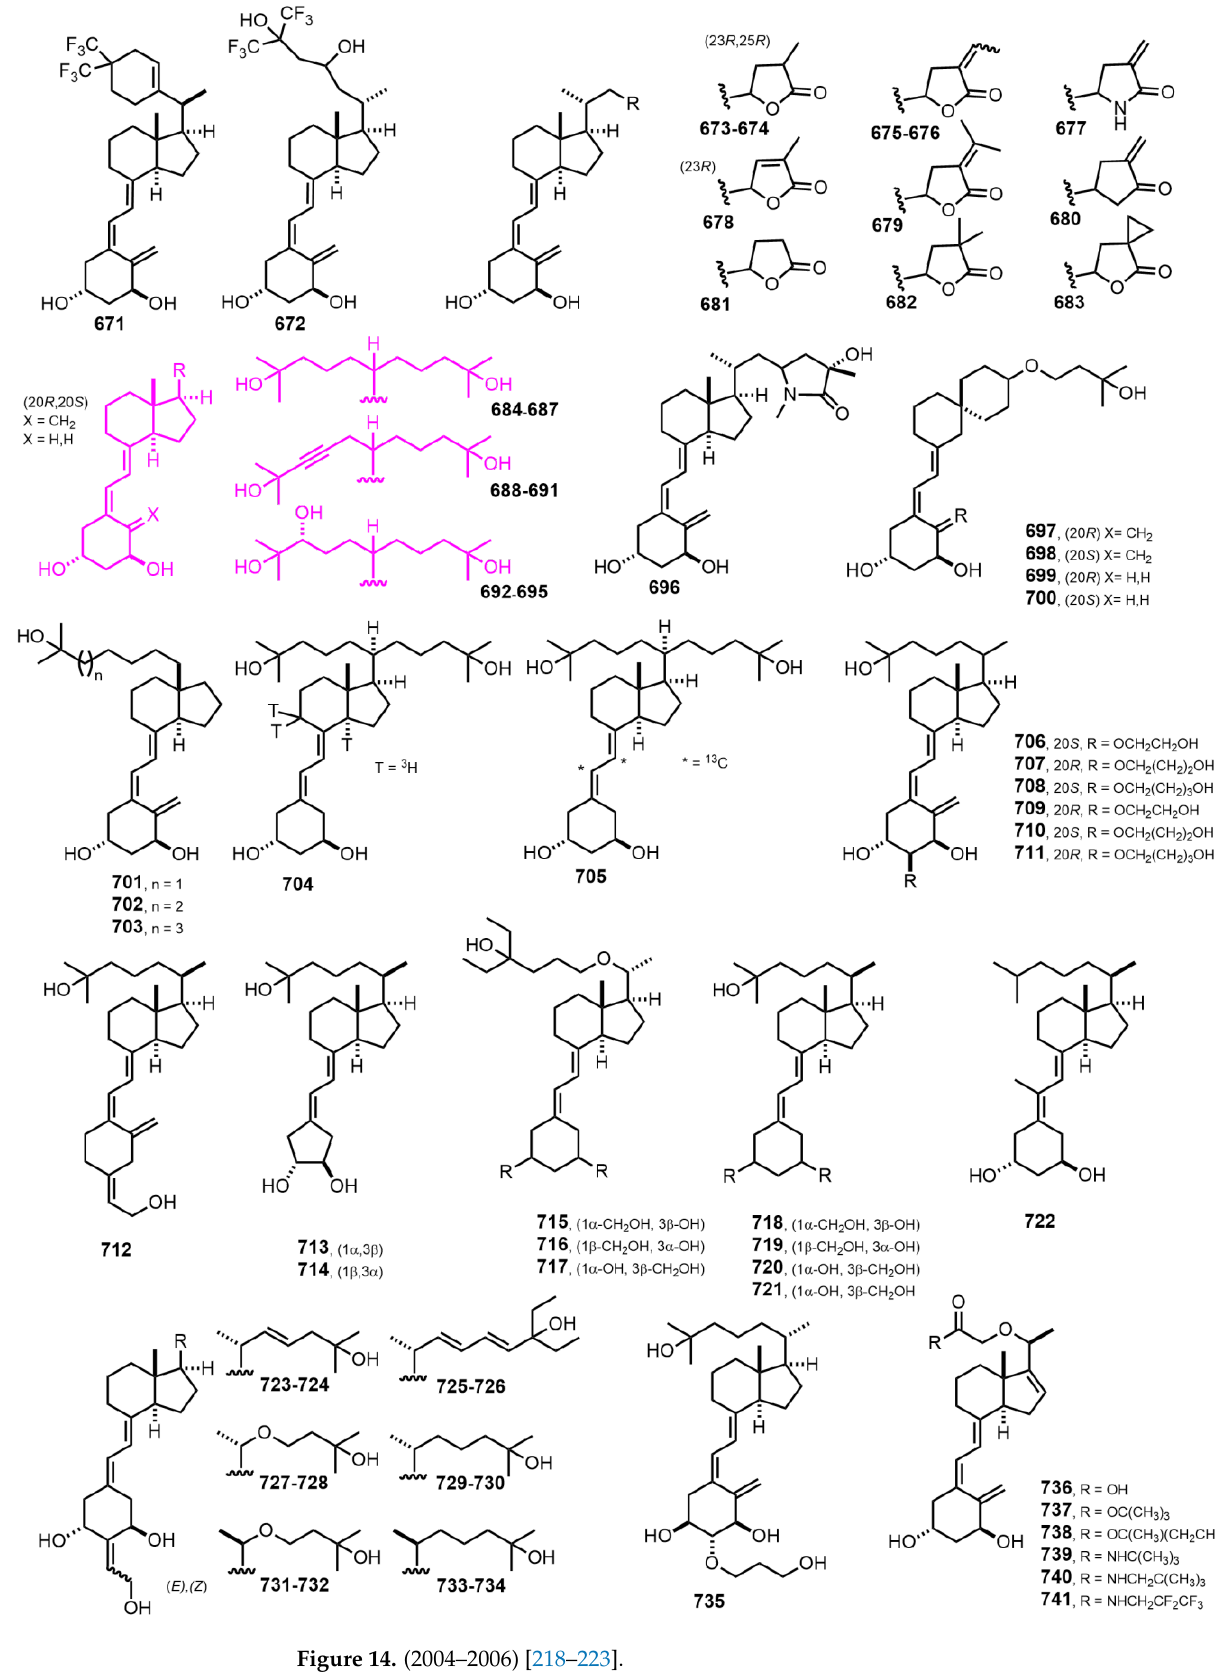
Figure 14. (2004–2006)